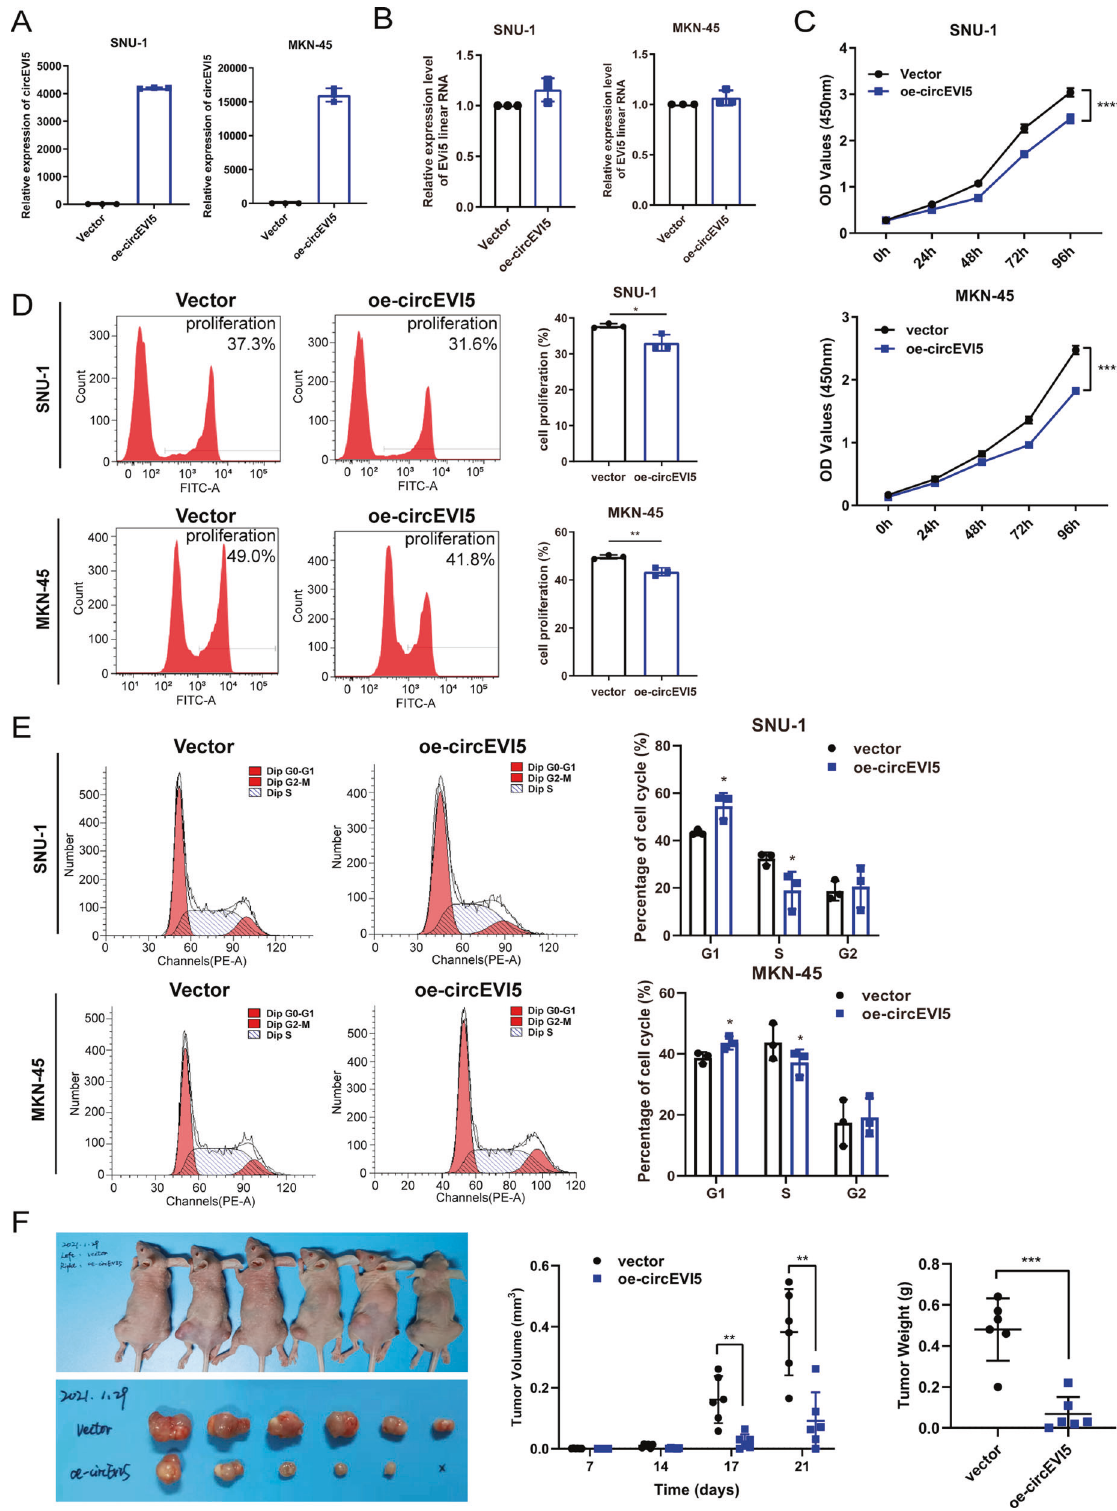
Fig. 2 circEVI5 suppressed cell proliferation and blocked cell cycle progression in GC cells. A – B The expression of circEVI5 and EVi5 linear RNA was veri fi ed by qRT-PCR after stable transfection with circEVI5 or control vector in SNU-1 and MKN-45 cells. C – D The CCK-8 assay and EdU incorporation assay were performed to detect the proliferation of SNU-1 and MKN-45 cells transfected with circEVI5 or control vector. E Representative images of PI-stained cell cycle analysis by using fl ow cytometry. F Xenograft models were built by inoculating circEVI5 or control vector cells subcutaneously into the backs of BALB/c nude mice, n = 6. The tumor volume was periodically measured and tumor growth data points were plotted. After 21 days, the mice were euthanized, and tumor tissues were excised and weighed. Overexpression of circEVI5 is represented as oe-circEVI5. Data were shown as the mean ± SD of three independent experiments. * p < 0.05, ** p < 0.01, *** p < 0.001, **** p < 0.0001. Cell Death and Disease (2021)